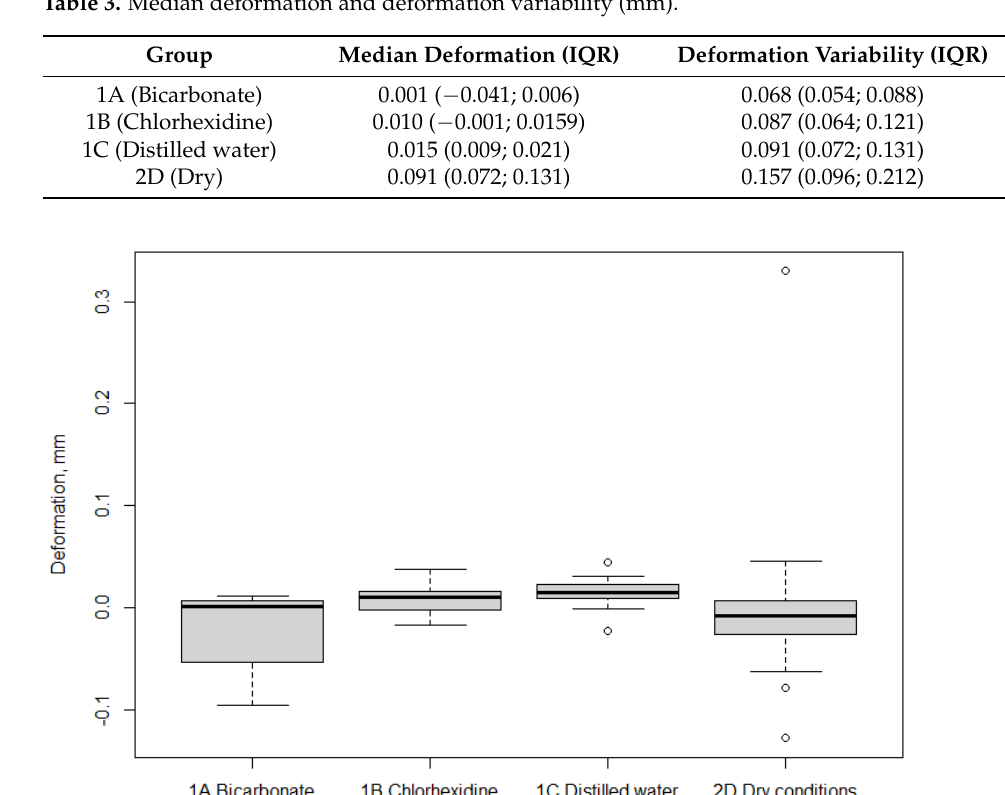
Figure 3. Deformation data profiles of the four groups: bicarbonate (1A), chlorhexidine (1B), distilled water (1C), and dry conditions (2D). Box and whiskers plot.